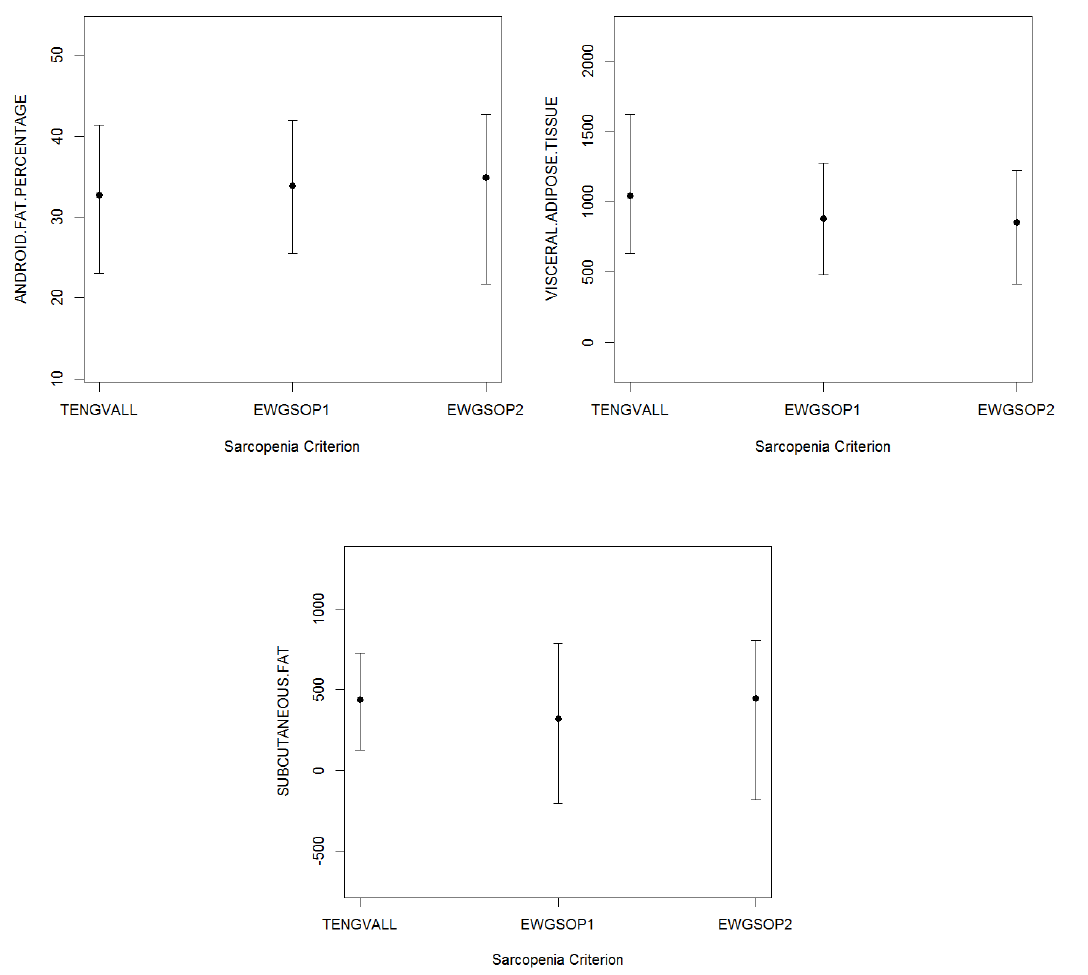
Figure A8. Summary for patients with low ASMI characteristics under each diagnostic criterion. The points represent medians, while lower and upper quartiles are represented by the vertical bars.